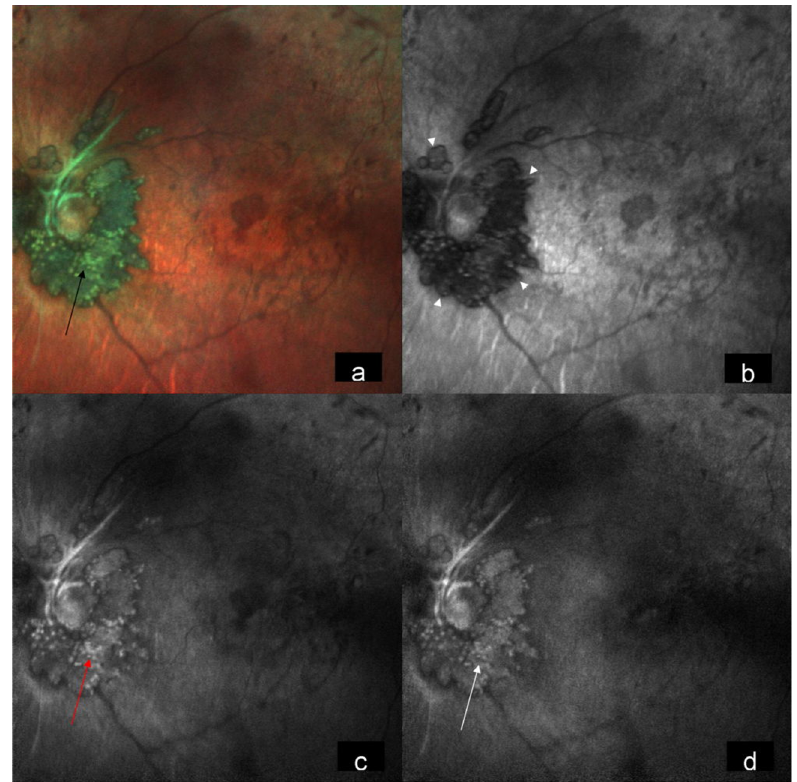
Figure 5: Multicolor image of the left eye highlighting mulberry appearance of the lesion with green shift signifying elevated lesion (a) (black arrow). In infrared reflectance, the lesion is hyporeflective with its margins well visualized (b) (arrow heads). Green reflectance (c) (red arrow) and blue reflectance (d) (white arrow) show multiple hyperreflective